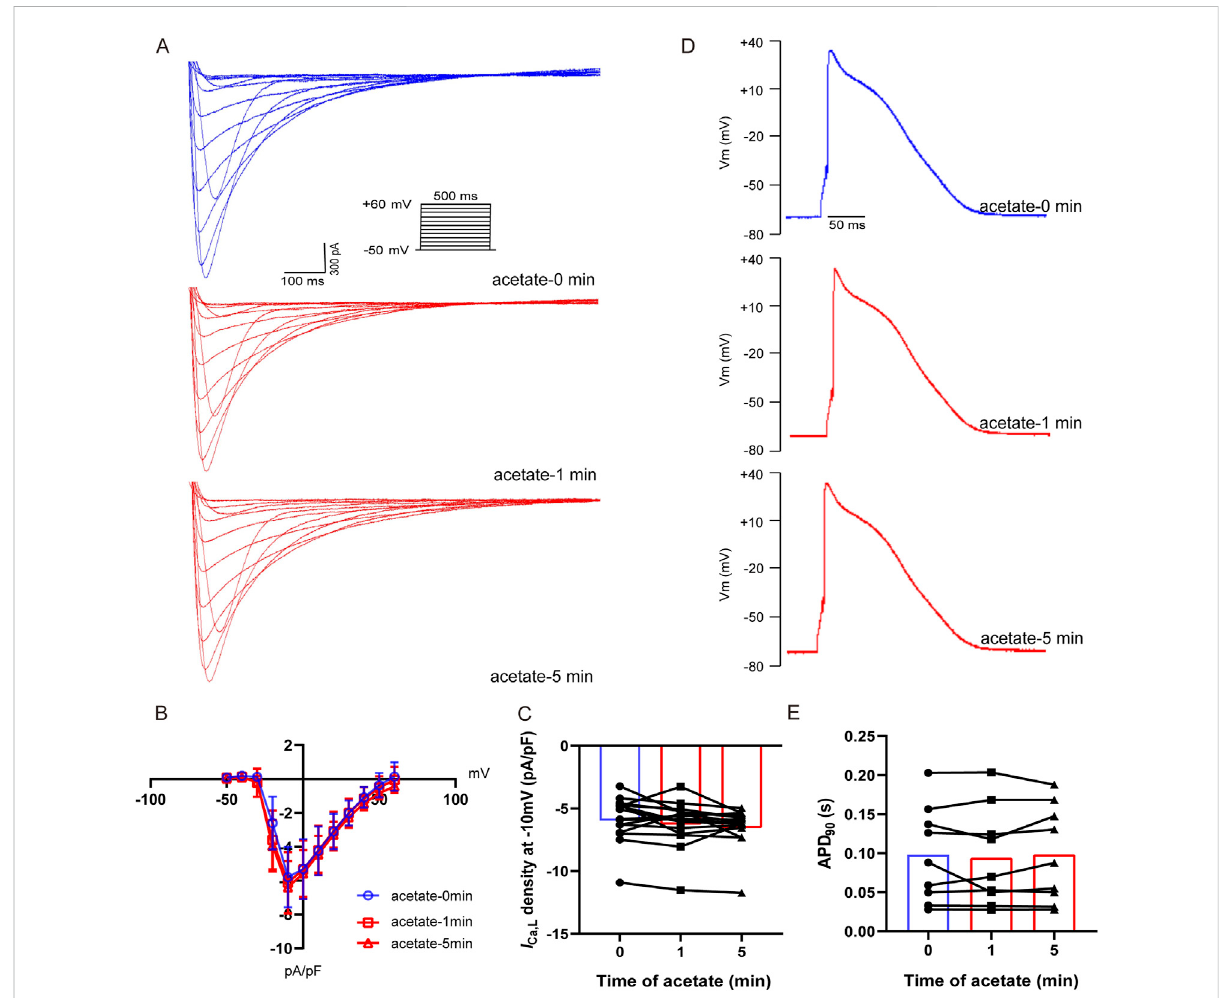
FIGURE 5 Acetate had no effect on the activity of L-type calcium current and action potential in rat ventricular myocytes. Recording of L-type calcium current from isolated cardiomyocytes (A) . Current density-voltage curve for L-type calcium current in cardiomyocytes with or without acetate (B) , N = 5, n = 16. The max current density for L-type calcium current in cardiomyocytes (C) , N = 5, n = 16. Representative action potential recordings in ratventricularmyocytebeforeandafterperfusionwithacetate (D) .90%ofthedurationofactionpotentialincardiomyocytes (E) , N =5, n =9.N: the number of rats, n: the number of